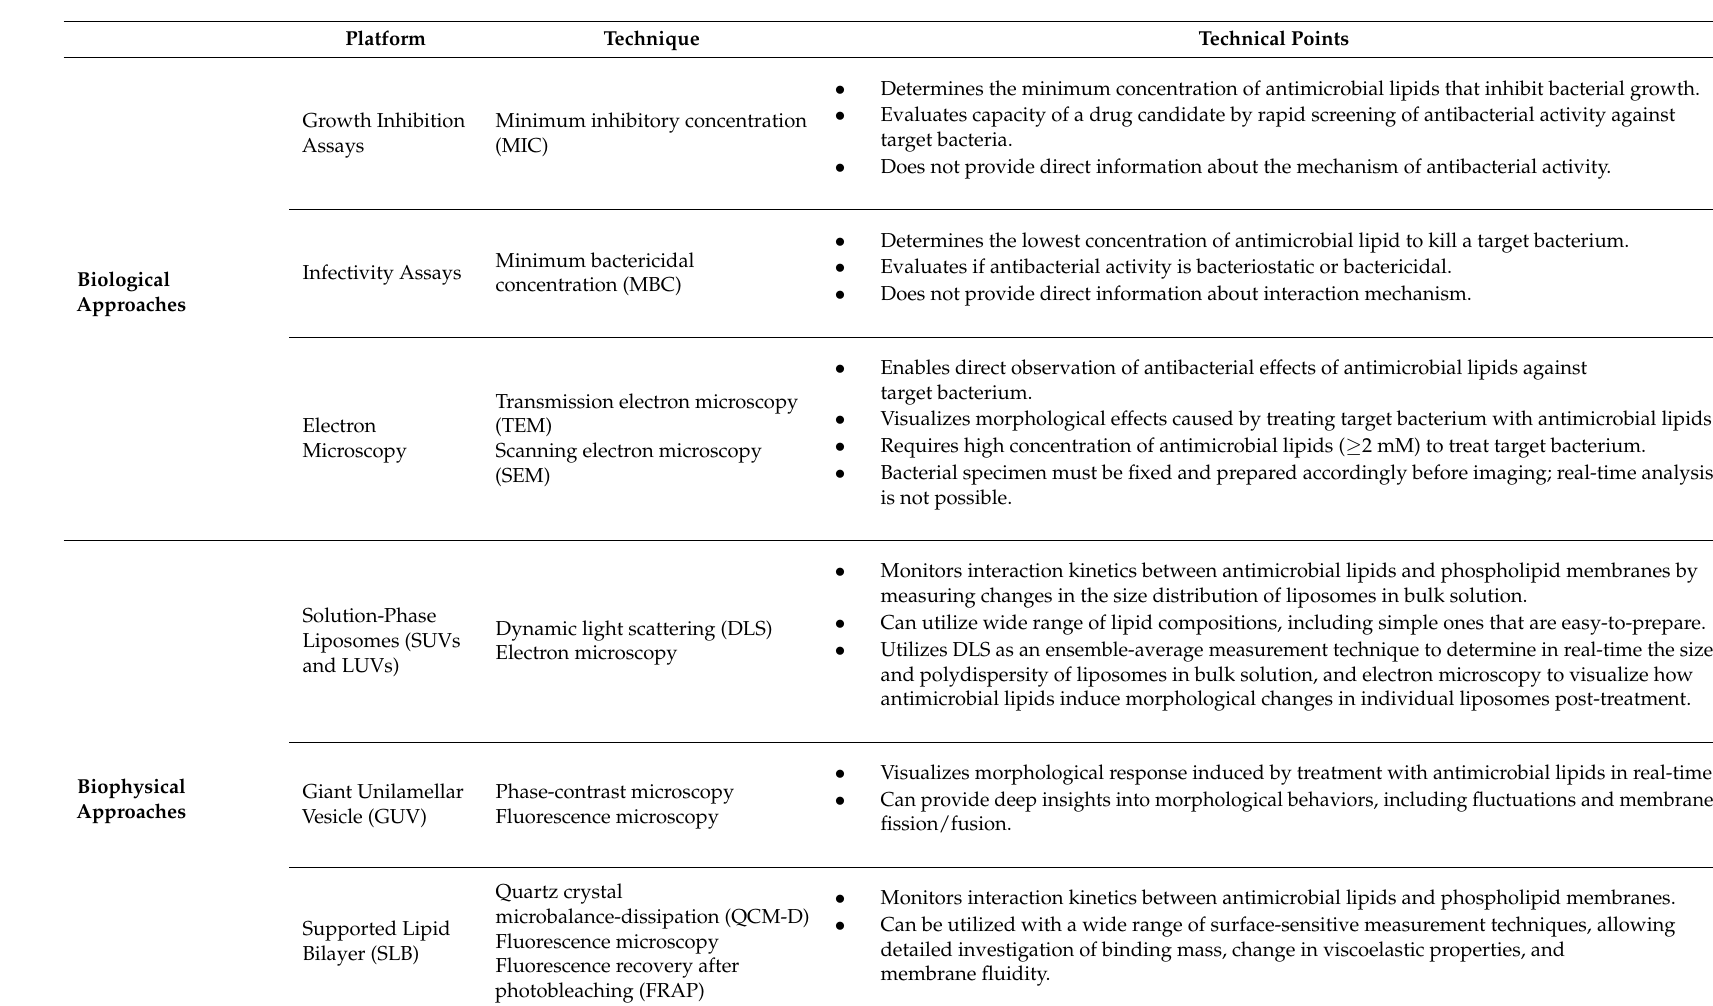
Table 2. Summary of experimental approaches to characterize antimicrobial